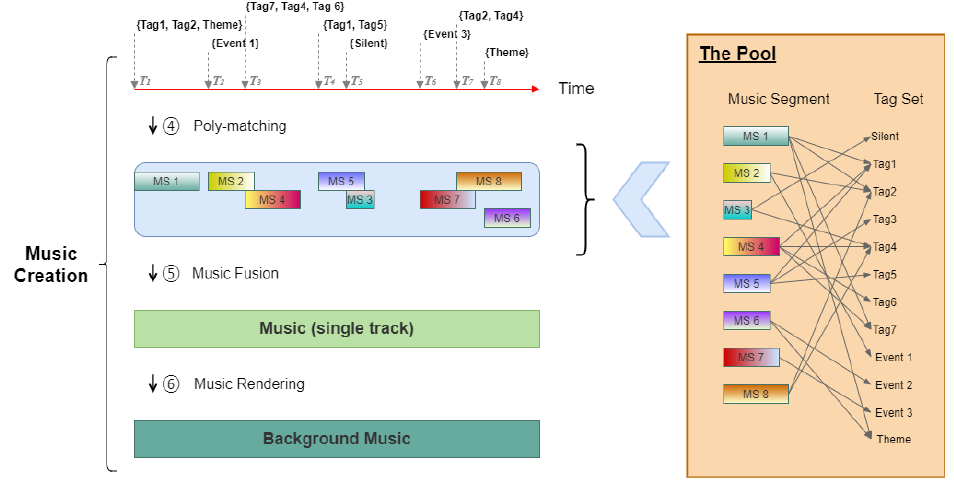
Figure 2. Music generation framework.